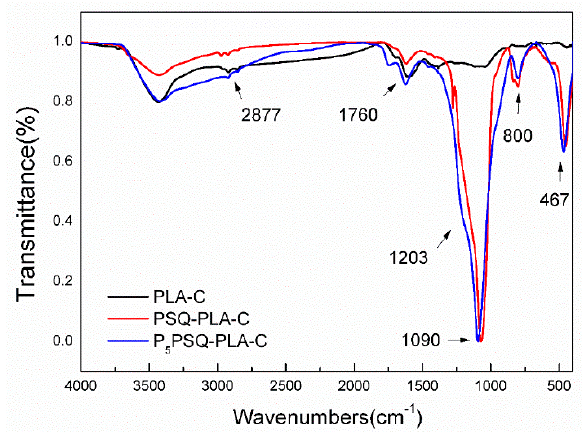
Figure 10. FT-IR spectra of the char residues of PLA and its flame retardant composites.